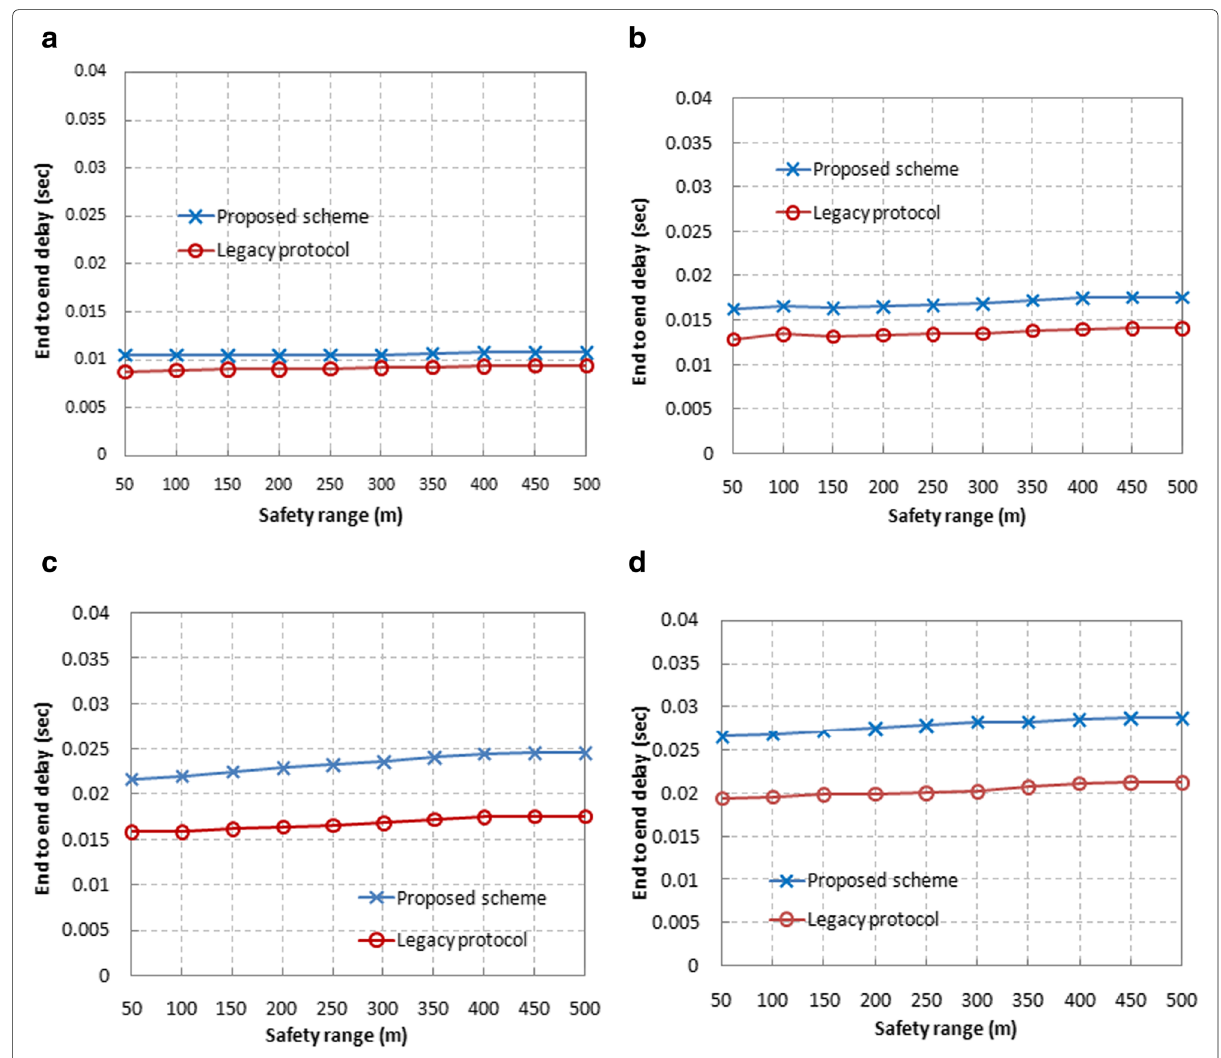
Fig. 4 a – d End-to-end delay. a 40-node network, b 60-node network, c 80-node network, d 100-node